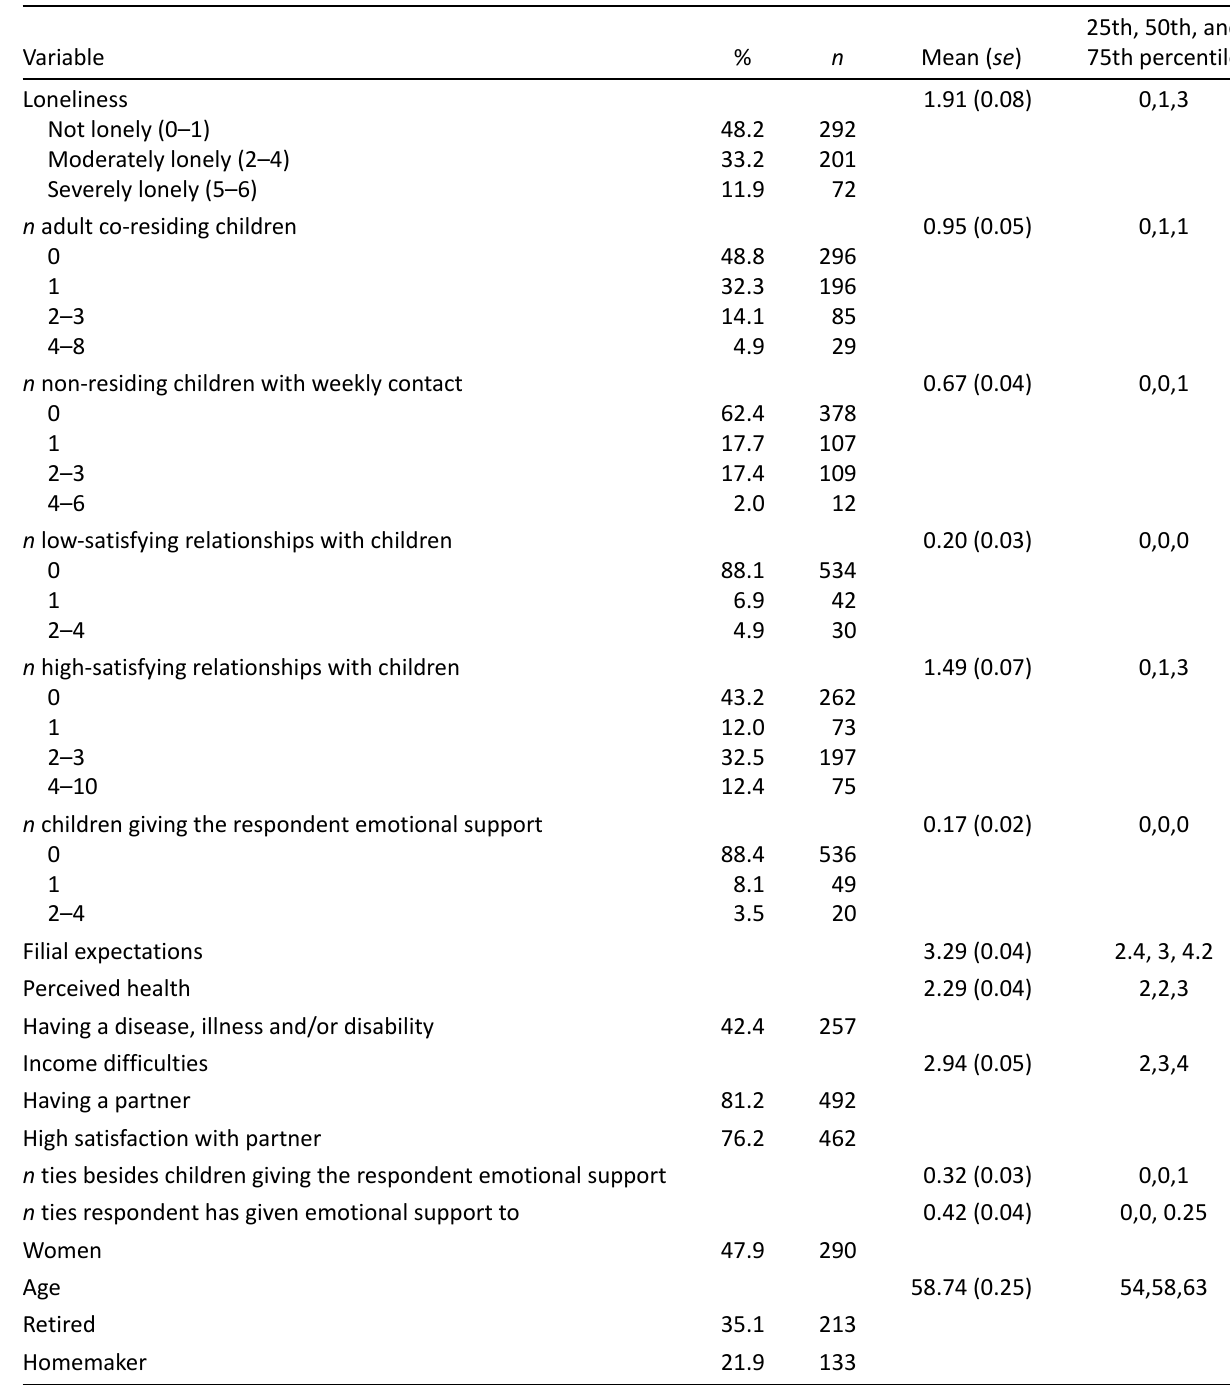
Table 1. Descriptives of older Turkish migrants living in Germany (n =